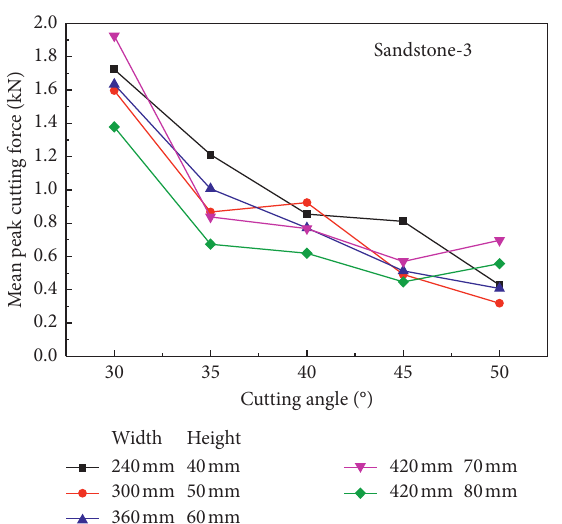
Figure 16: The variation of mean peak cutting force with cutting angle.